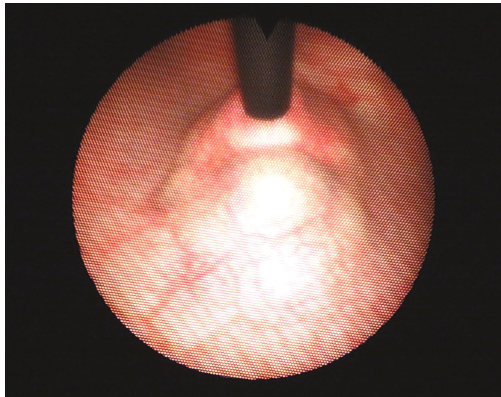
Figure 3: Cystoscopic photo of unde fi ned, raised lesion in the bladder wall anterolateral to the